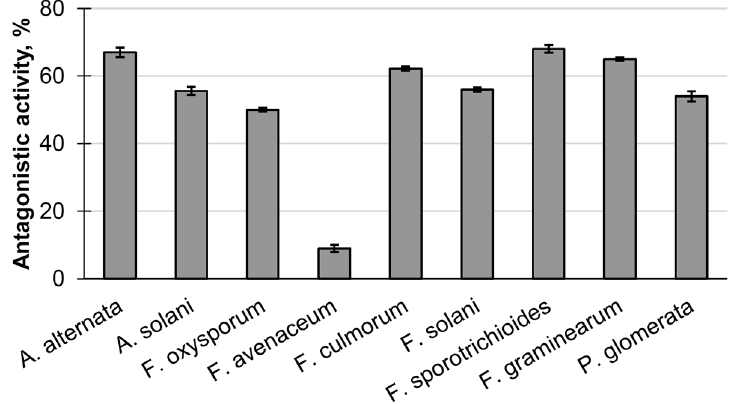
Figure 5. Calculated antagonistic activity of Penicillium chrysogenum F-24-28 towards the studied plant pathogenic fungi. The measurements were made at the 7th day of